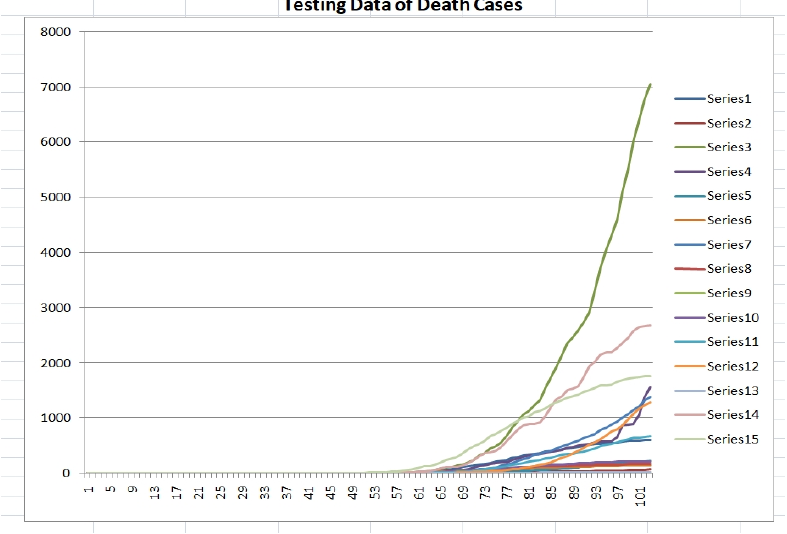
Figure 12. Testing dataset of the death cases for the 15 countries (1 April 2020 to 12 July 2020). Table 3. Validation of the Fuzzy Fractal Classification Method with 15 countries.